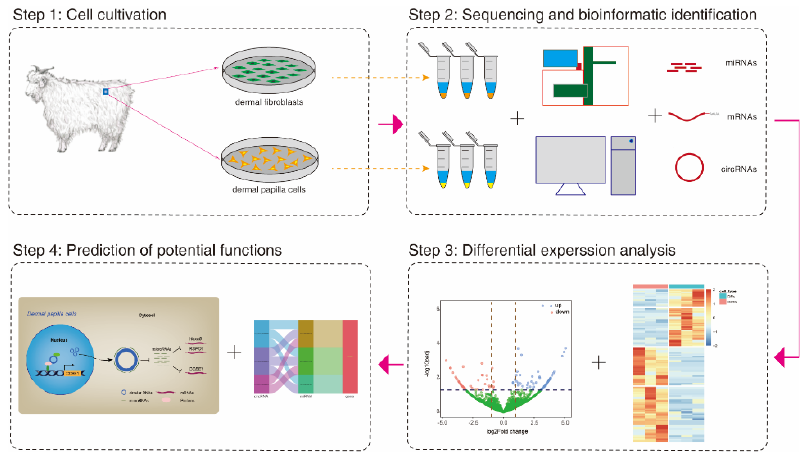
Figure 1. Workflow of present study. Cell cultivation and profiling of miRNAs and mRNAs were finished in a previous study [26].